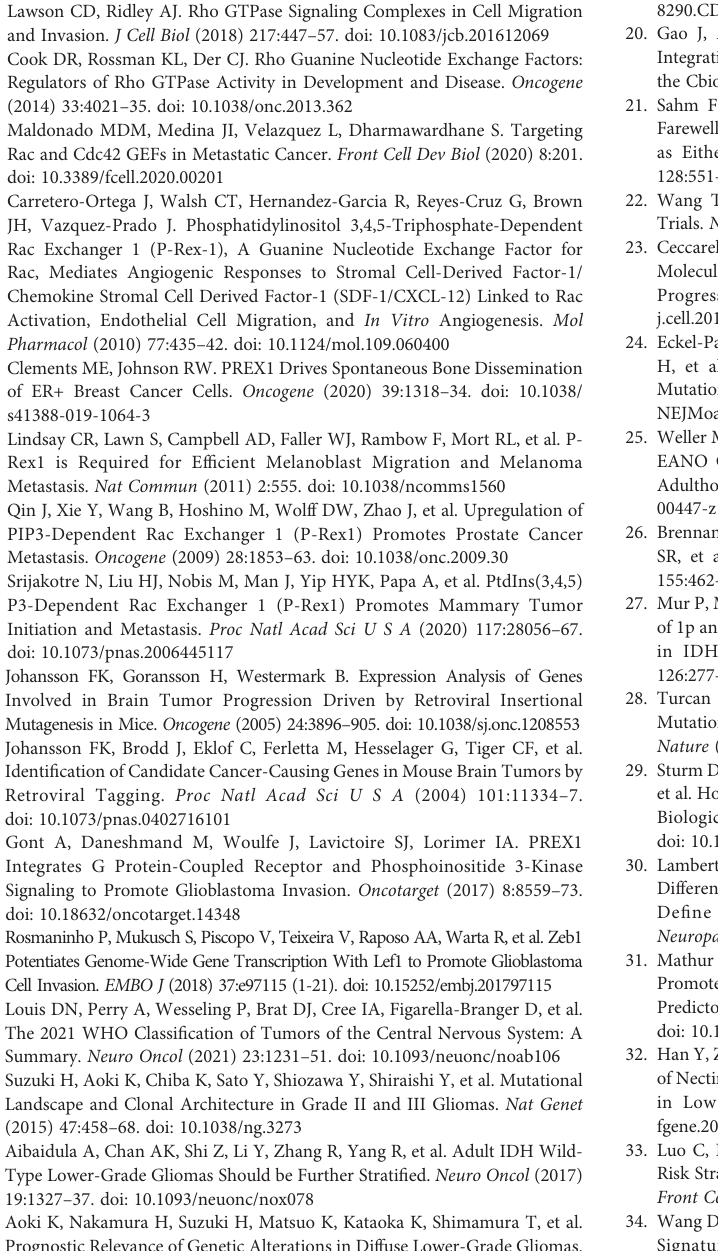
Supplementary Figure 2 | The P-Rex1 signaling hub signature correlates with transcriptional signatures characteristic of myeloid cells. The PREX1 signaling hub signature was analyzed in the METASCAPE platform to identify the cell types, de fi ned by characteristic transcriptional signatures, that express a signi fi cant number of the same genes (77). Myeloid and endothelial cells were preferentially identi fi ed with the PREX1 signaling hub